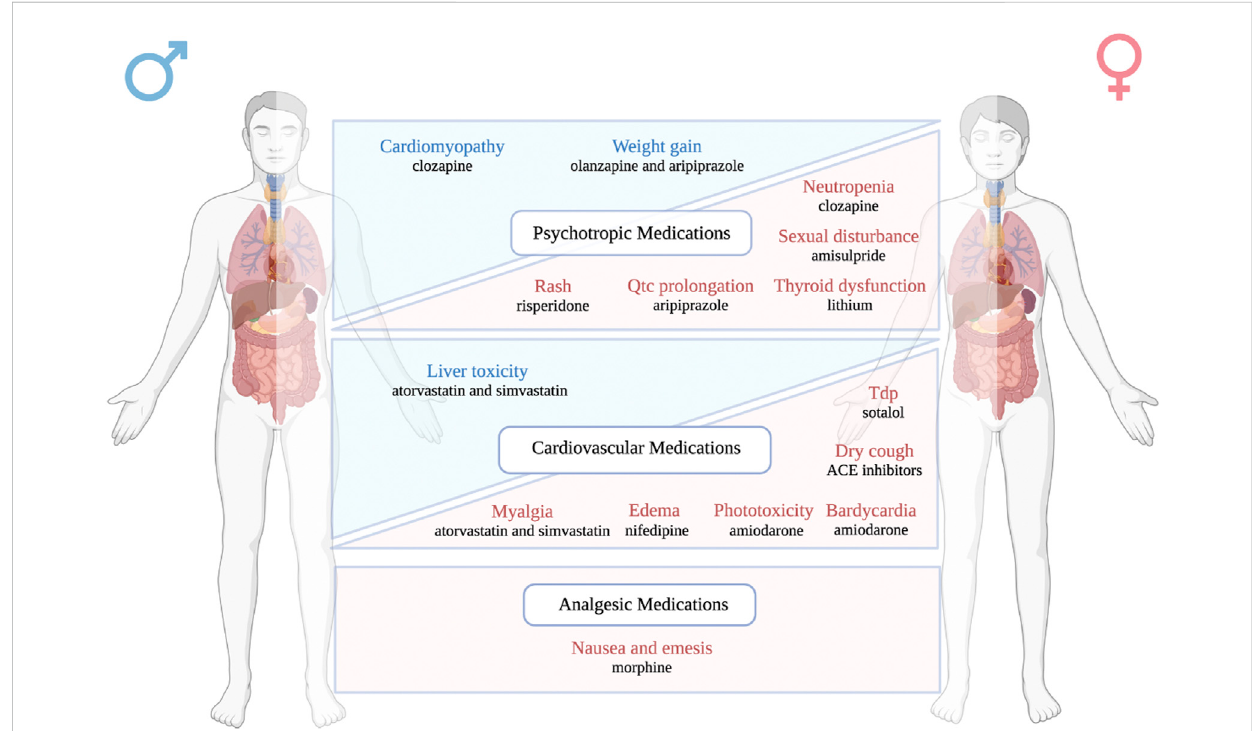
FIGURE 2 Aschematic fi gurelistingthemainADRsshowingsexdifferencesinoccurrencerate.Theadversedrugreactionshighlightedinbluearemale-biased ADRs, while the adverse drug reactions highlighted in red are female-biased ADRs. Drugs and their associated sex biased ADRs are classi fi ed into three different therapeutic categories: psychotropic medications, cardiovascular medications, and analgesic